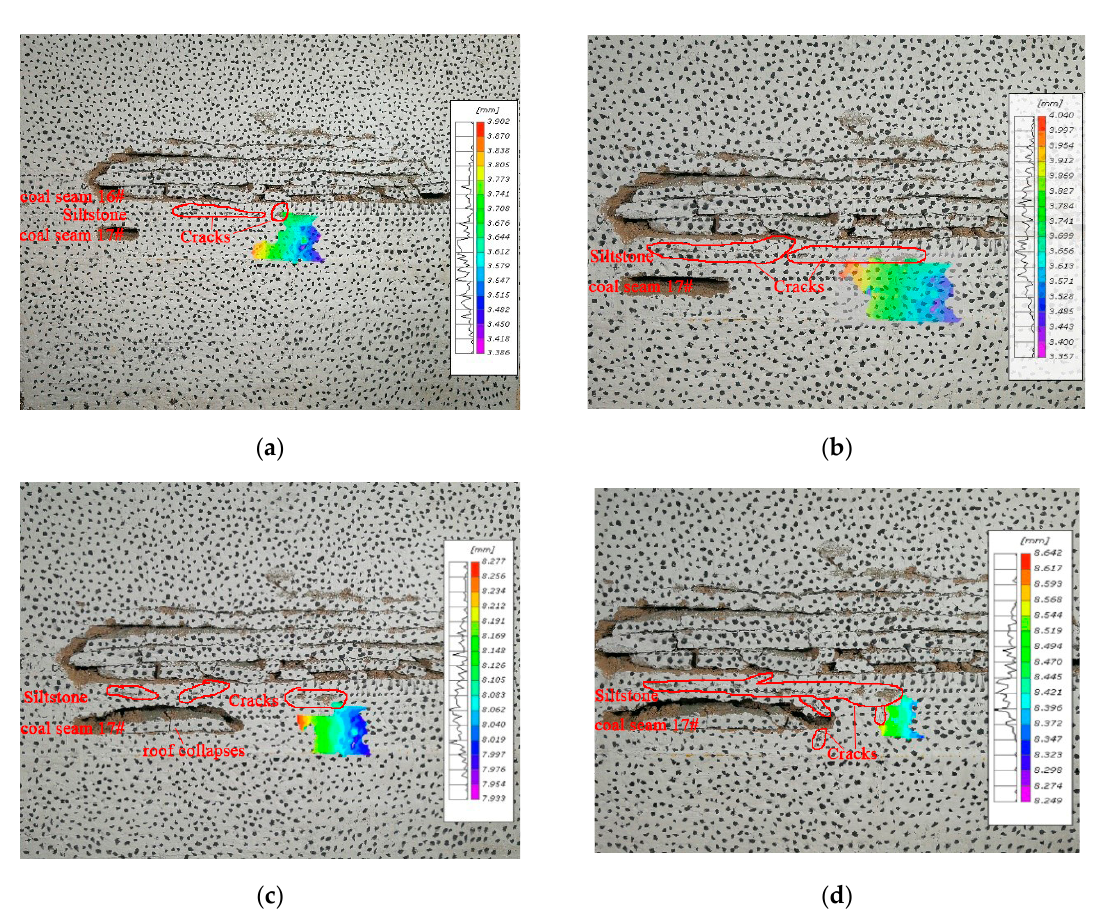
Figure 10. Excavation simulation plan diagram of coal seam 17#.